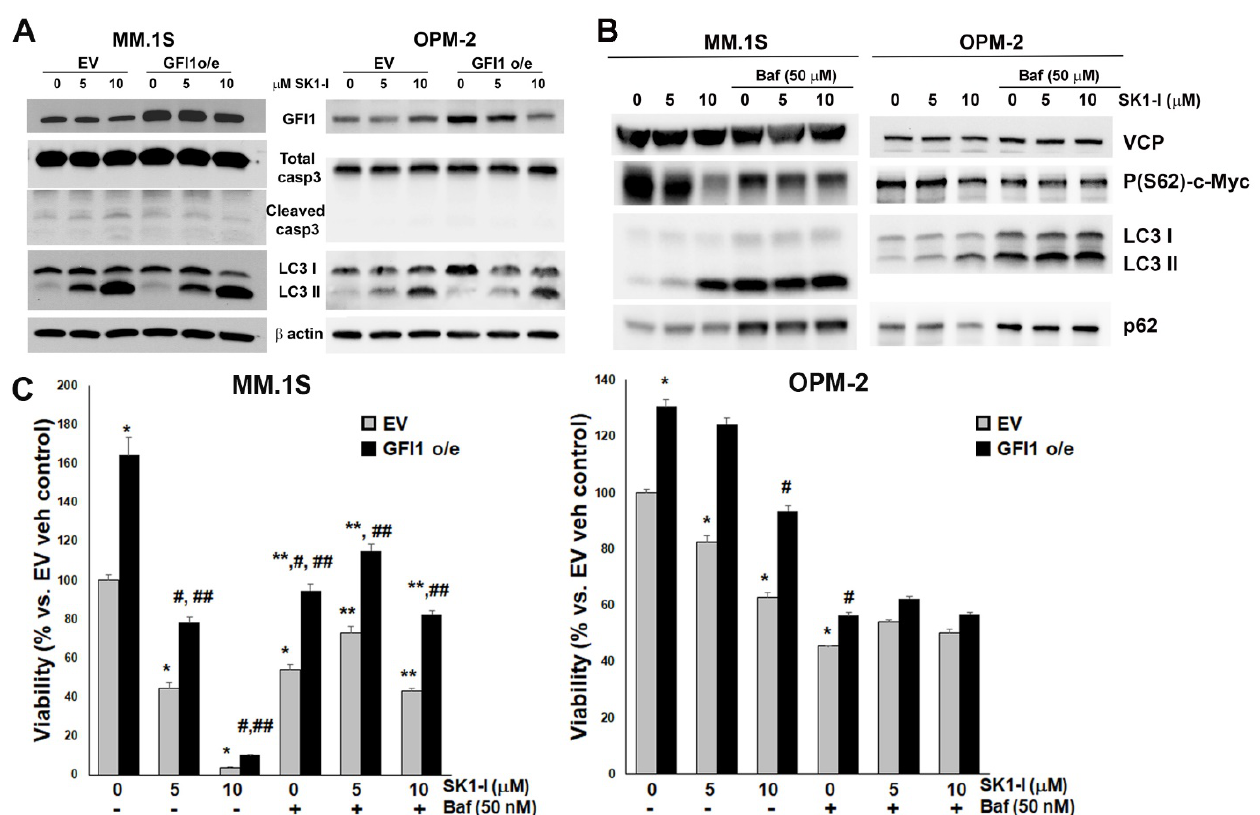
Figure 7. Insufficient intracellular S1P in MM cells induces cell death via autophagy. MM.1S and OPM-2 cells were treated with SK1-I (5 and 10 μM) or vehicle control (DMSO shown as 0) for 24 h ( A , B ) or 48 h ( C ) and pre-treated or not with Baf (50 nM, 2 h) ( B , C ). Whole cell lysates were probed by WB with indicated specific antibodies and presented by representative immunoblots ( A , B ) (original data in Figure S6). Viability was measured by AlamarBlue assay and reported as percent vs. EV vehicle treated control ( p < 0.0005 in both MM.1S and OPM-2 panels: * vs. vehicle control; ** vs. respective SK1-I treatments alone; # vs. GFI1 o/e vehicle control and ## vs. EV respective treatments) ( C ).